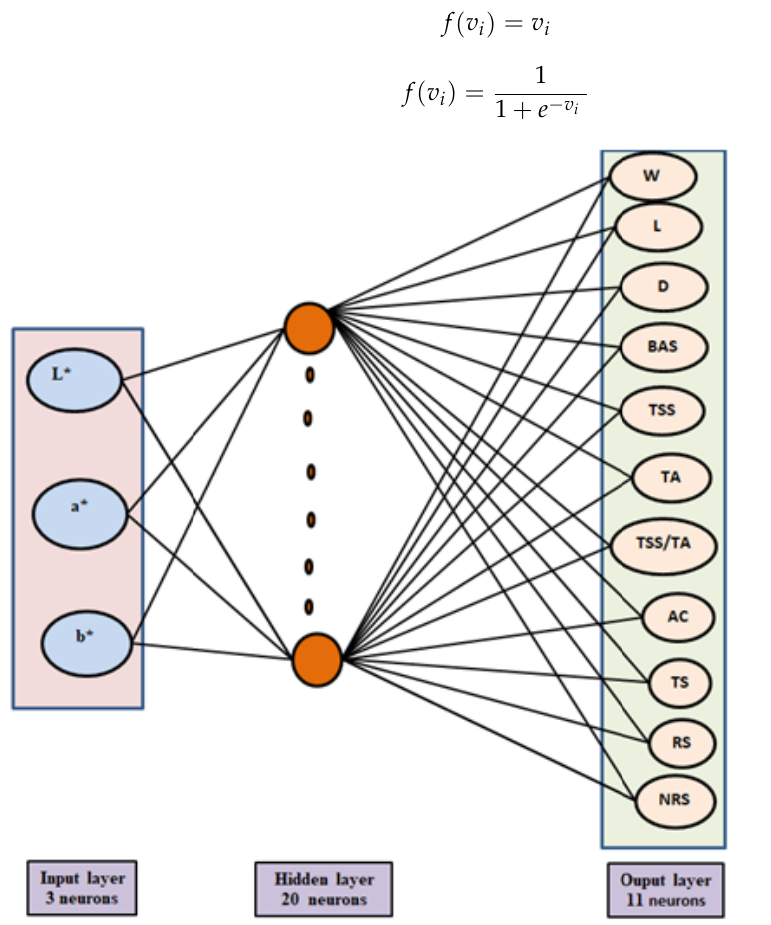
Figure 1. Structure of the multi-layer perceptron artificial neural network. The output parameters are berry weight (W), berry adherence strength (BAS), total soluble solids content (TSS), berry length (L), berry diameter (D), titratable acidity (TA), TSS/titratable acidity, anthocyanin (AC), total sugars (TS), reducing sugars (RS), and non-reducing surges (NRC). The input variables are L* = lightness; a* = redness; b* = yellowness.